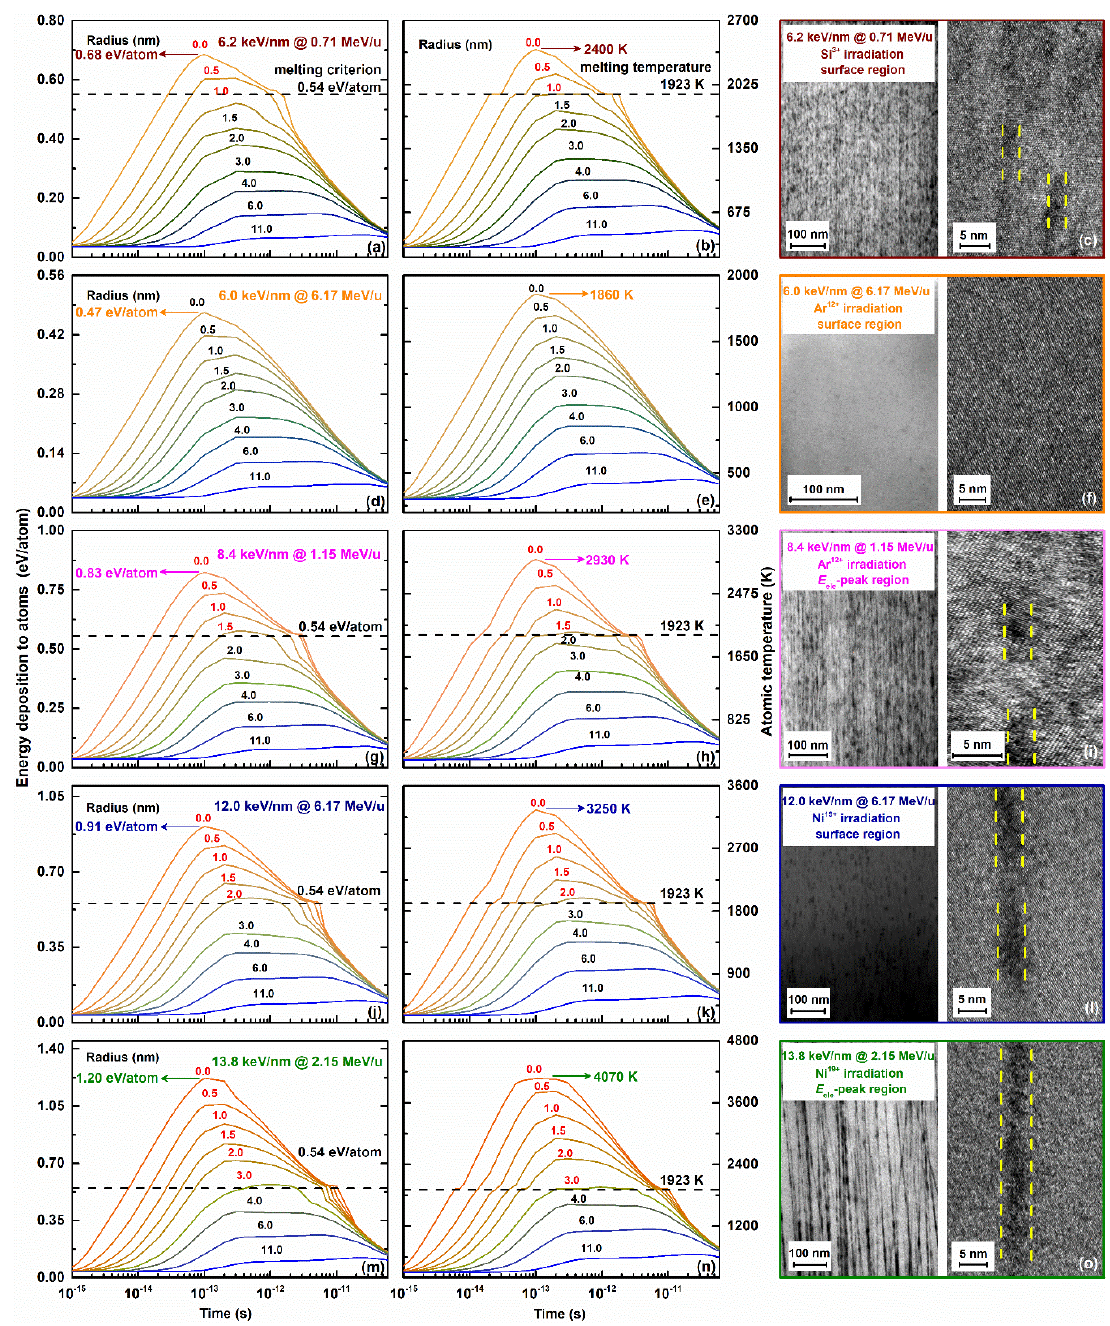
Figure 2. ( a , d , g , j , m ) Energy deposited to atoms and ( b , e , h , k , n ) corresponding evolution of atomic temperature at different radii versus time under the action of ion irradiation with different ion velocities and electronic energy losses. ( c , f , i , l , o ) TEM-observed latent tracks with different morphologies in LiTaO 3 under different irradiation conditions.